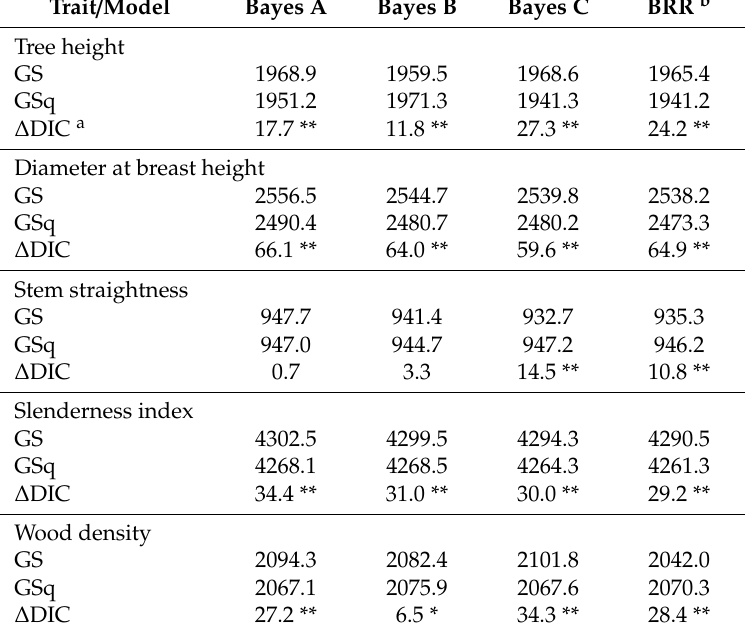
Table 1. Deviance information criterion (DIC) of genomic prediction in Eucalyptus cladocalyx based on (i) polygenic background (pedigree information) and all informative markers (GS model) and (ii) polygenic background, QTL-genotype e ff ects (determined by GWAS) and SNP markers that were not associated with any trait (GSq